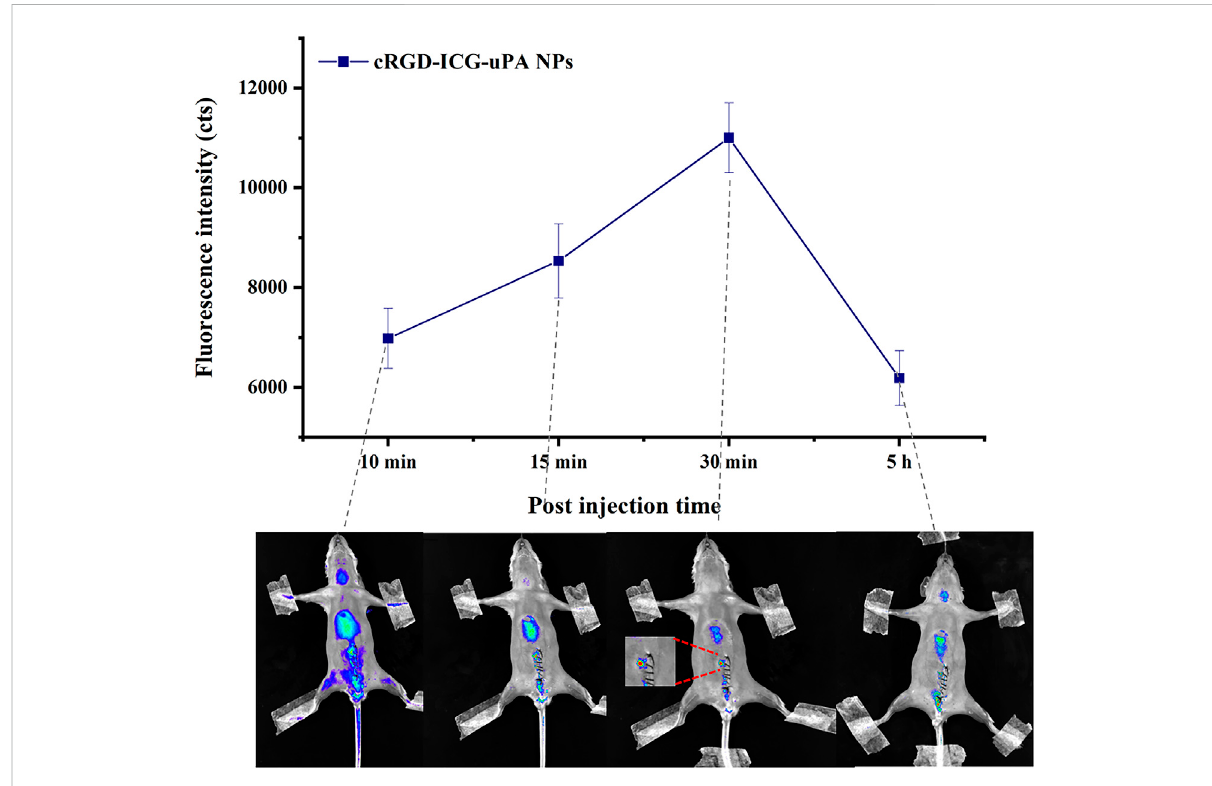
FIGURE 7 The average fl uorescence intensity of thrombus after intravenous injection of cRGD-ICG-uPA NPs (20 U/g) on mouse mesenteric vascular thrombosis models, and in vivo fl uorescence images at representative time points ( n =